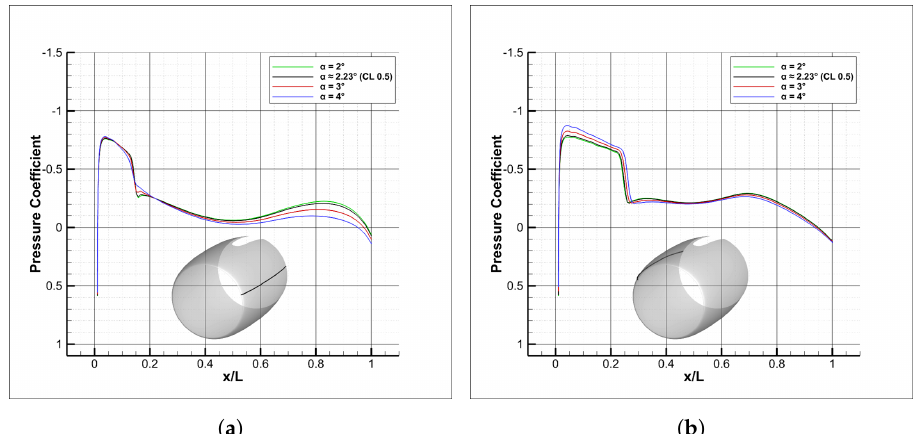
Figure 6. Pressure coefficient distribution on inboard and outboard nacelle external cowl at increasing incidence: ( a ) inboard and ( b ) outboard.